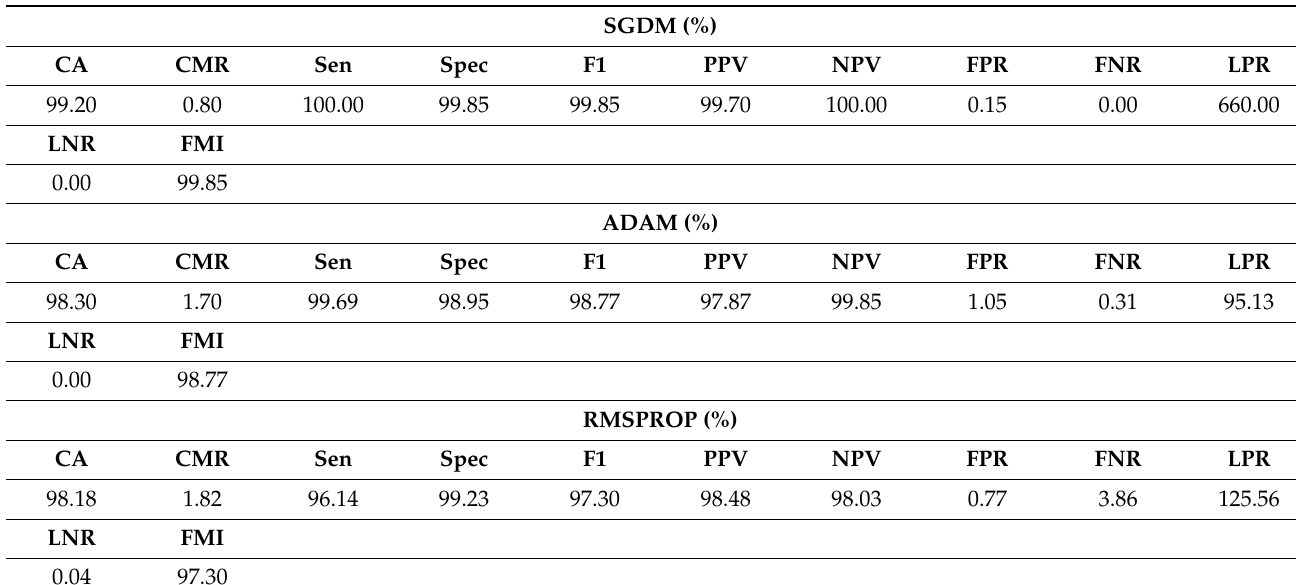
Table 10. Statistical parameter results for the proposed model for kidney cancer prediction empow- ered with IoMT and transfer learning (augmented test